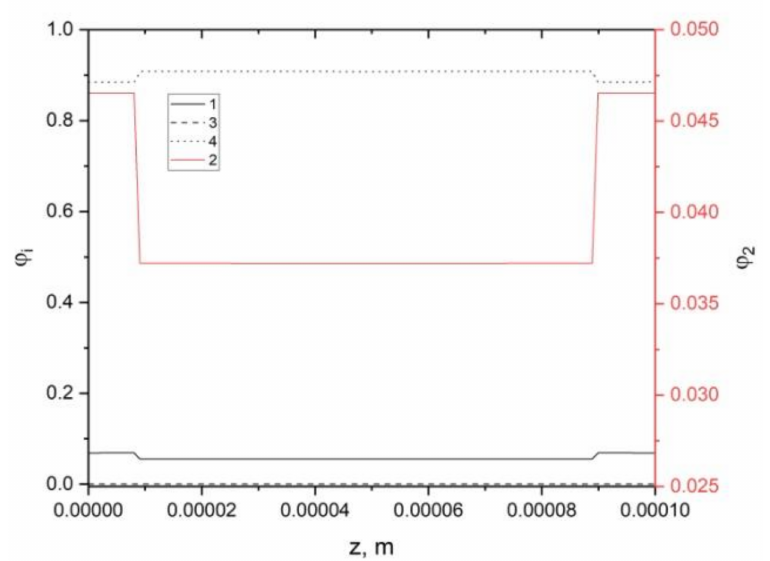
Figure 15. Distribution of volume fractions of phases under the influence of a low-intensity surface forest fire depending on the thickness of the leaf at time t = 5 s (summer, July, +20 ◦ C, ϕ 30 = 0.2, α s = 0.05): 1—dry organic matter, 2—soot particles, 3—moisture,